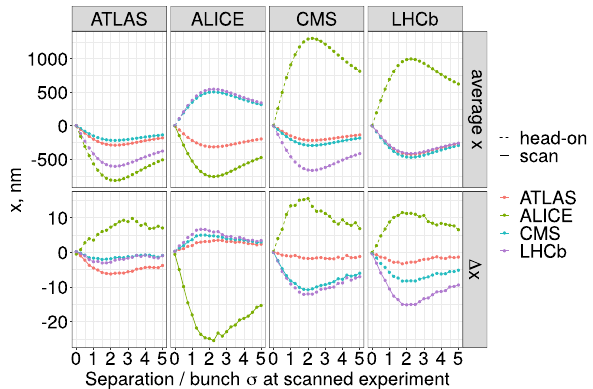
Fig. 9 Upper row: x -coordinate averaged over the first bunch at four experiments, lower row: its deviation from (3.40) approximation, both in nm, versus the beam separation expressed in the bunch widths. The column labels denote the scanned interaction points (marked by the solid lines in the plots), at other points the beams collide head-on (the dashed lines). The simulation is the same as in Fig. 8